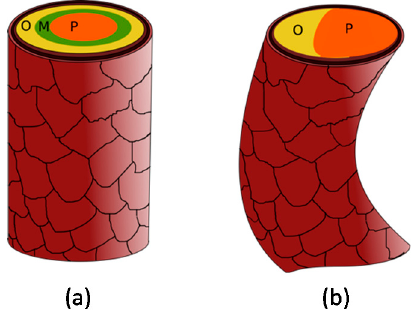
Figure 7. Scheme of distribution of orthocortical (O), mesocortical (M) and paracortical (P) cells in straight ( a ) and curly ( b ) hair fibers, as suggested in the study of Thibaut et al. [9].